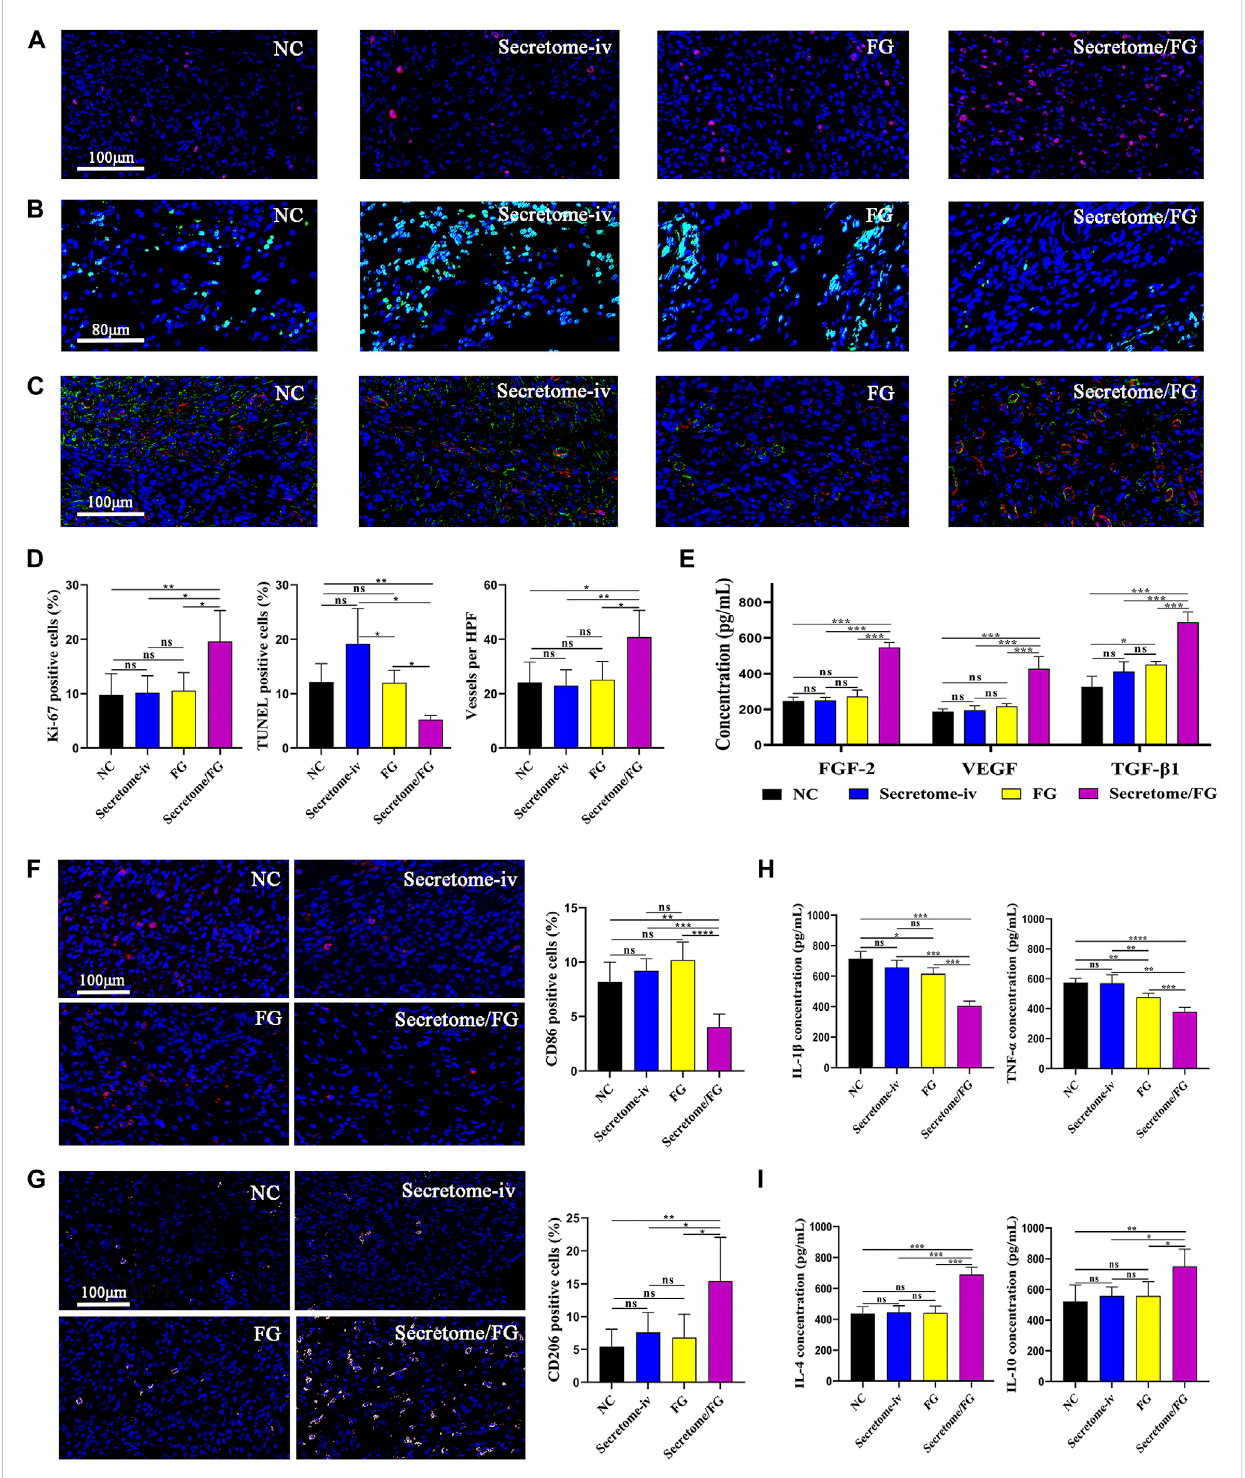
FIGURE 5 Secretome/FGcreates abene fi cialtissue microenvironment for thehealing ofintestinal anastomosis. (A,B, andC) Immuno fl uorescence staining of proliferation, apoptosis, and neovessel formation in regenerated granulation tissues for the different interventions. (D) Quantitative analysis of proliferation (A) ,apoptosis (B) ,andneovesselformation (C) ( n =5pergroup;ANOVA). (E) QuantitativeanalysisofFGF-2,VEGF,andTGF- β 1inregenerated granulation tissues by ELISA for the different interventions ( n = 5 per group; ANOVA). (F, G) The immuno fl uorescence staining results show that the Secretome/FG treatment achieves the lowest proportion of M1 macrophage polarization (CD86) and the highest proportion of M2 macrophage polarization (CD206) in the regenerated granulation tissues among all of the interventions. (H, I) ELISA quanti fi cation of pro-in fl ammatory factor (IL-1 β , TNF- α ) and anti-in fl ammatory factor (IL-4, IL-10) in regenerated granulation tissues for the different interventions ( n = 5 per group; ANOVA). **** p < 0.0001, *** p < 0.001, ** p < 0.01, * p < 0.05, ns ≥